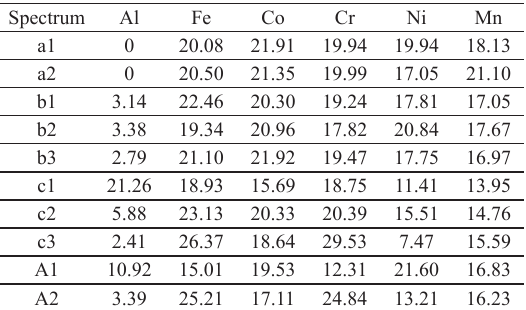
Figure 7. Wear loss of AlxFeCoCrNiMn high entropy